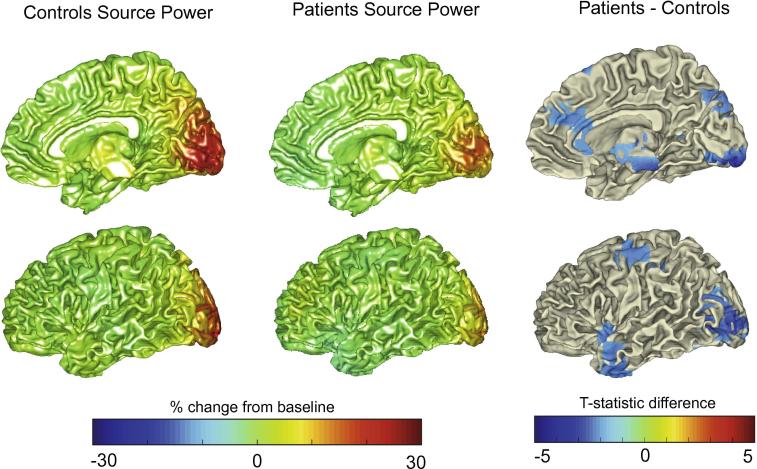
Beamformer contrast images (band-pass filtered 30–80 Hz) measured as percentage change between stimulus and baseline, projected onto a template brain surface. This is shown for controls (left column) and MS patients (middle column). The right column illustrates the t-statistic values for the difference between patients and controls (negative values indicating lower amplitude for patients than controls). Simply for illustration purposes, t-values are plotted here at the uncorrected level. The data were averaged over both eyes. Only right medial and lateral views are shown; the same trends were seen for left.